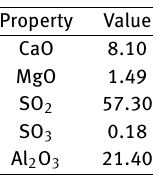
Table 4: Chemical composition of fly ash (%)